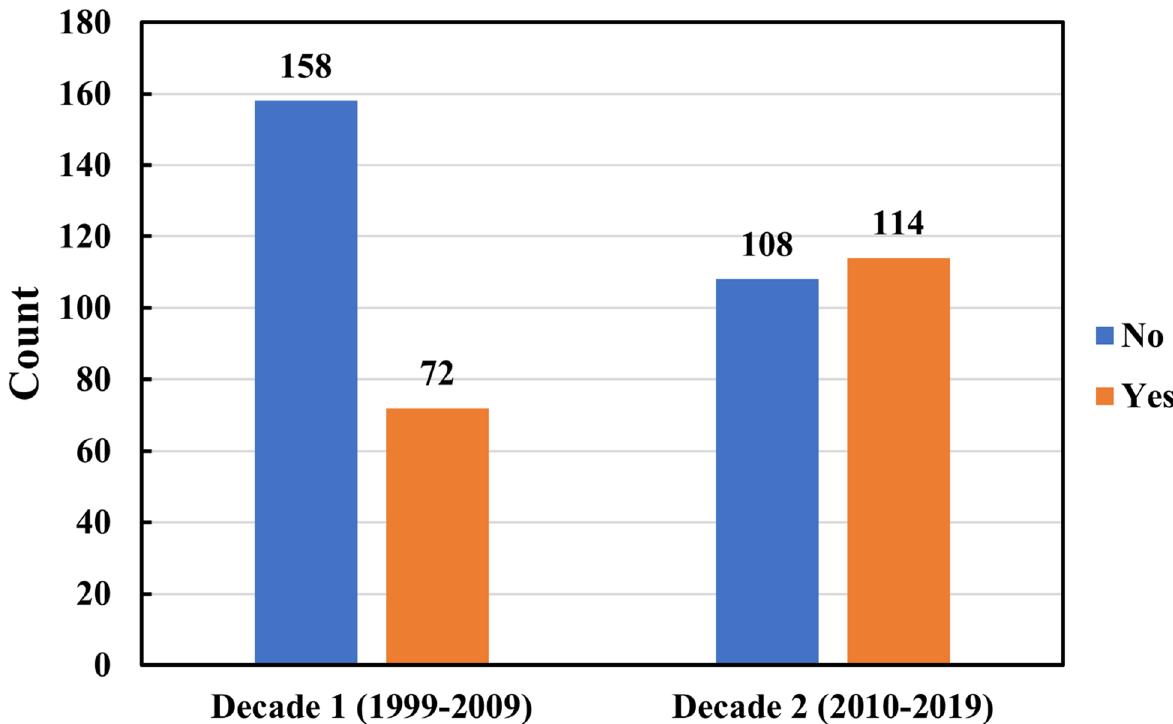
Fig. 12 Comparison between the 1 st and 2 nd decade regarding vascular invasion Fig. 12. This chart showed that, vascular invasion is statistically significantly higher in 2 nd